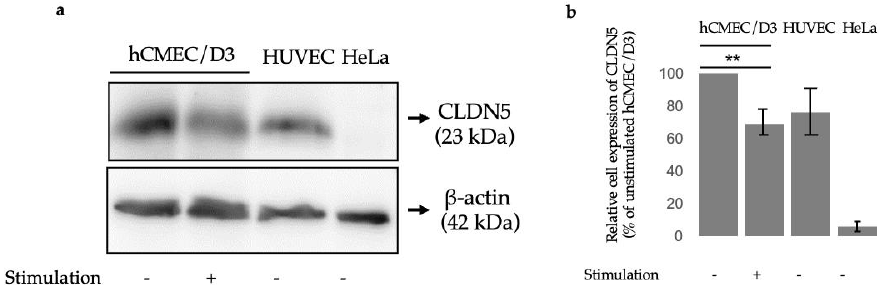
Figure 1. Claudin 5 protein expression levels ( a ) Representative immunoblots showing protein levels of claudin 5 (CLDN5) in hCMEC/D3 cells after no stimulation (-) or after TWEAK (100 ng/mL) stimulation (+) as compared to control cells (HUVEC and HeLa). ( b ) Quantification of Western blot normalized to unstimulated hCMEC/D3 cells; p ≤ 0.01 (**).